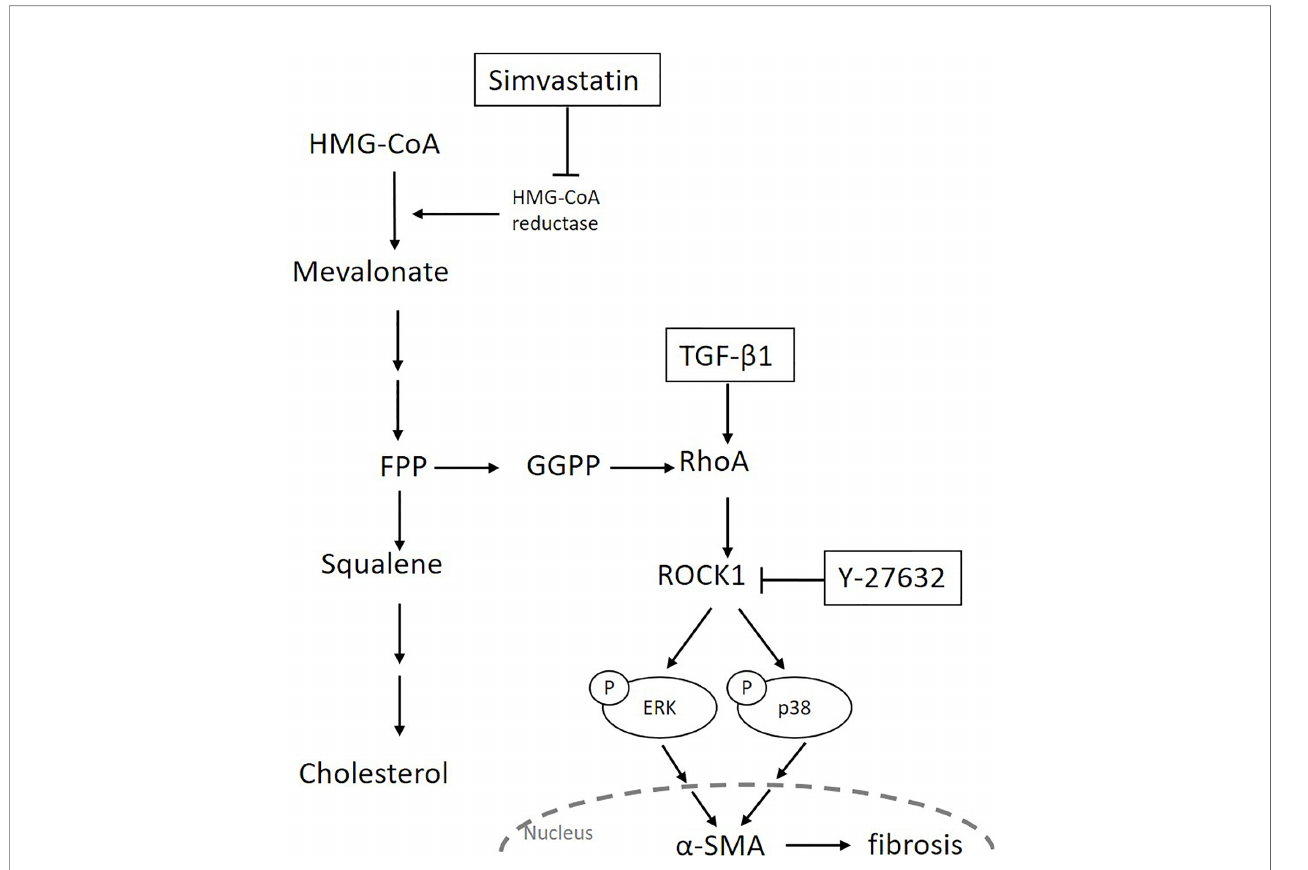
FIGURE 6 | Schematic diagram of the possible signaling mechanisms underlying simvastatin- and Y-27632-mediated inhibition of transforming growth factor- b (TGF- b 1)-induced orbital tissue fi brosis in Graves ’